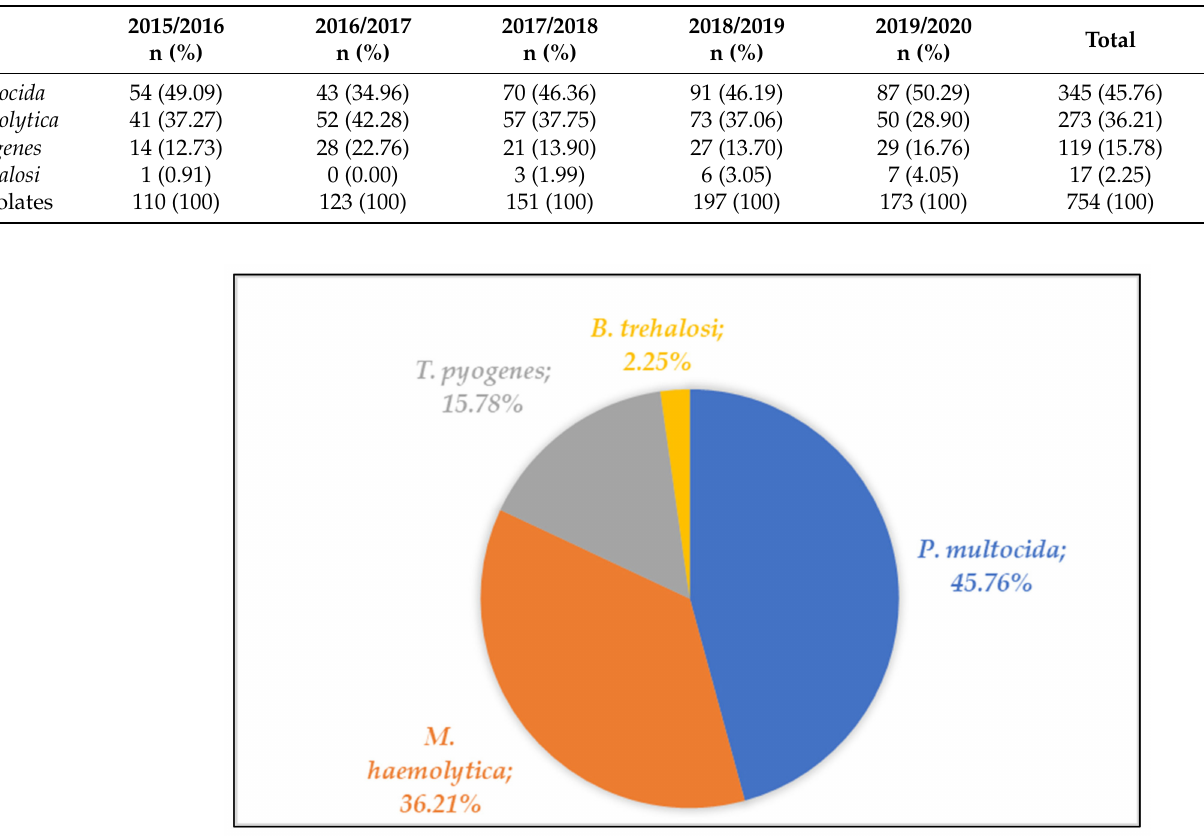
Figure 1. Overall proportion (%) of pathogens detected among the total number of analyzed